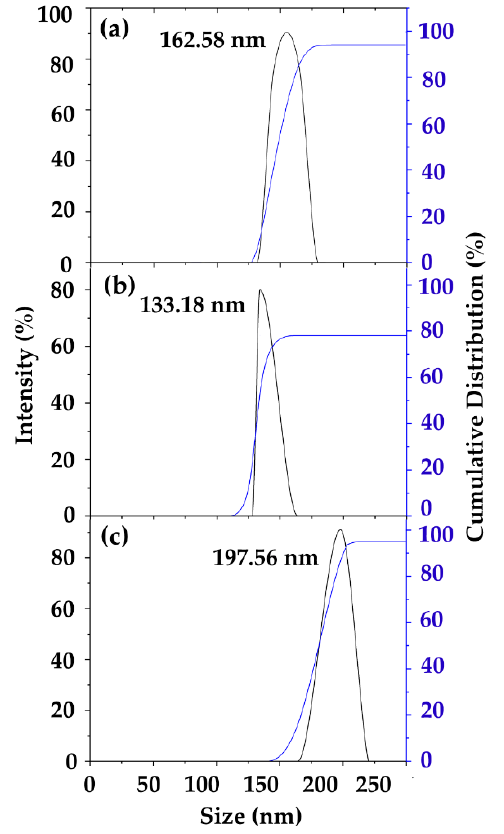
Figure 3. Hydrodynamic size distributions of ( a ) CF, ( b ) CS NPs and ( c ) CS-CF/5FU BNCs. Table 1. Hydrodynamic size of the synthesized samples in the solutions with various pH val- ues at 37 ◦ C. Data is expressed as the mean ± standard deviation for triplicates within an individual